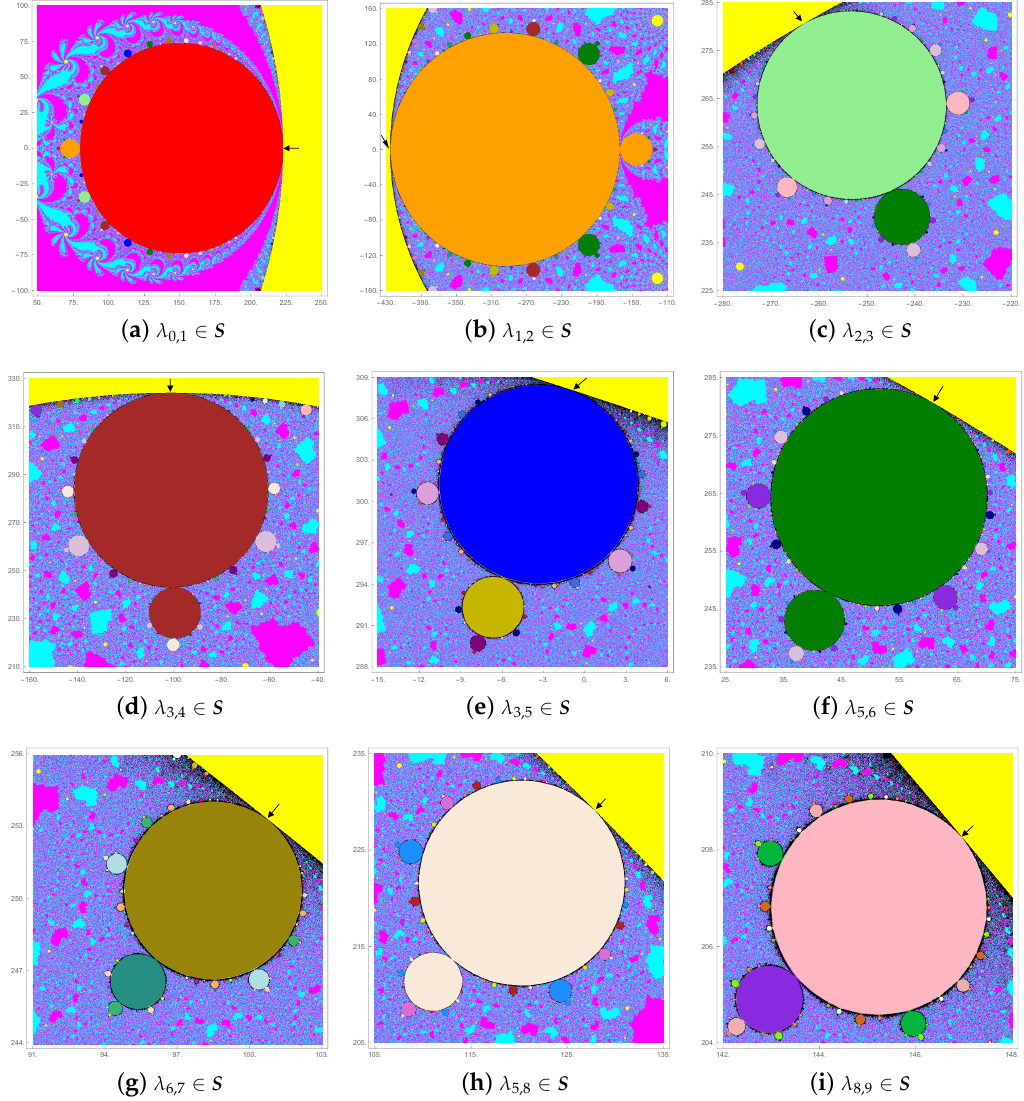
Figure 5. Bifurcation point λ (cid:96) , k of a period- k component H k along the stability circle S